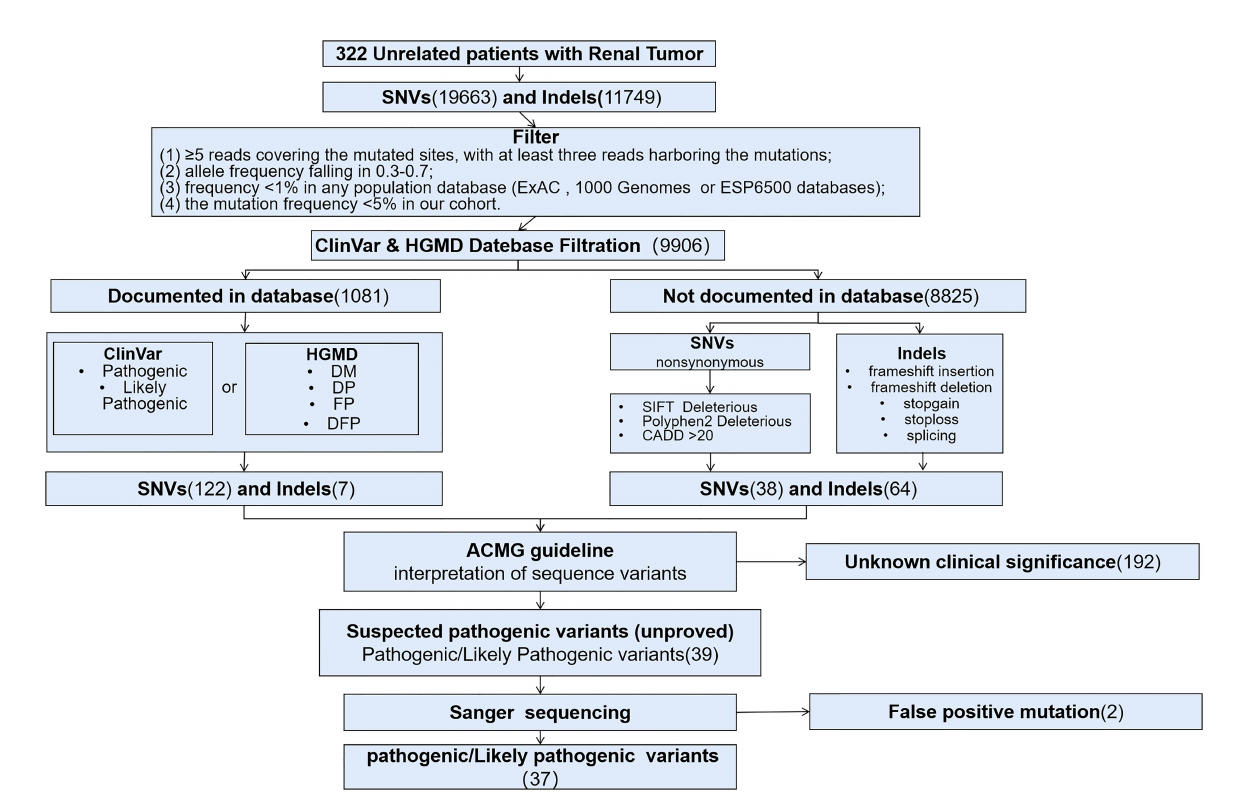
FIGURE 1 | Flow chart of the study design and the fi ltration of pathogenic variants and variants of unknown clinical signi fi cance. DM, Disease-causing mutation; DP, Disease associated Polymorphism; FP, functional polymorphism, DFP, Diseaseassociated polymorphism with functional